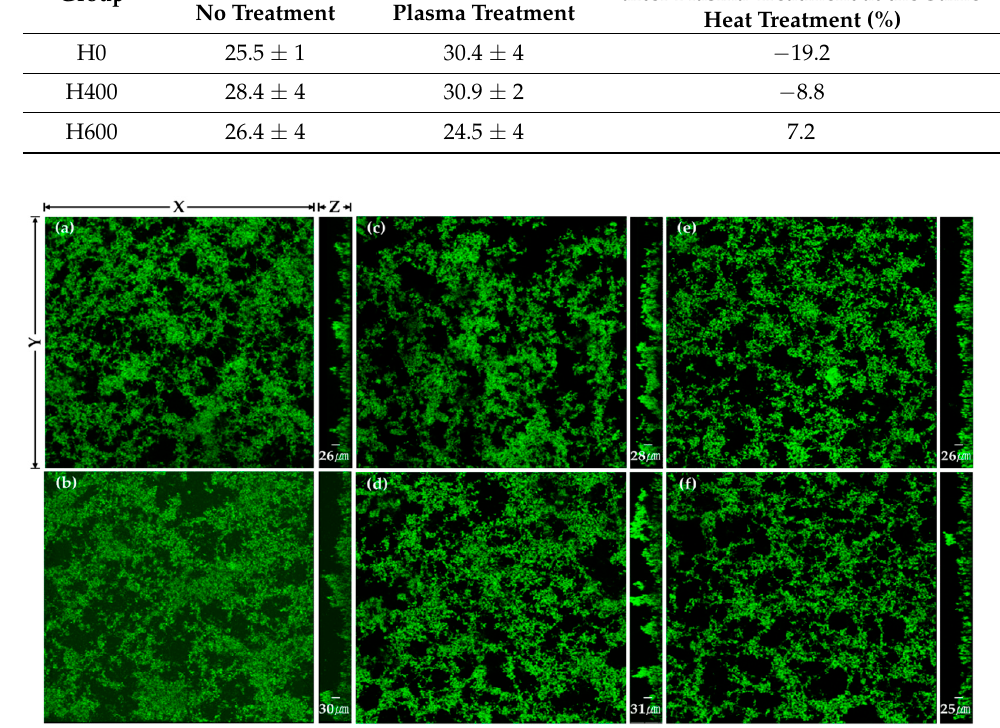
Figure 6. CLSM image of Porphyromonas gingivalis biofilm on ( a ) H0, ( b ) H0P, ( c ) H400, ( d ) H400P, ( e ) H600, and ( f ) H600P samples. Green fluorescence indicates viable cells.